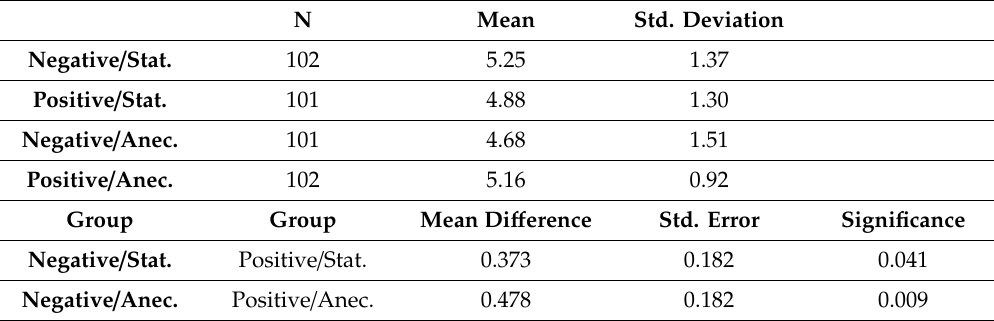
Table 10. Follow-up contrast analysis (frame and message evidence).